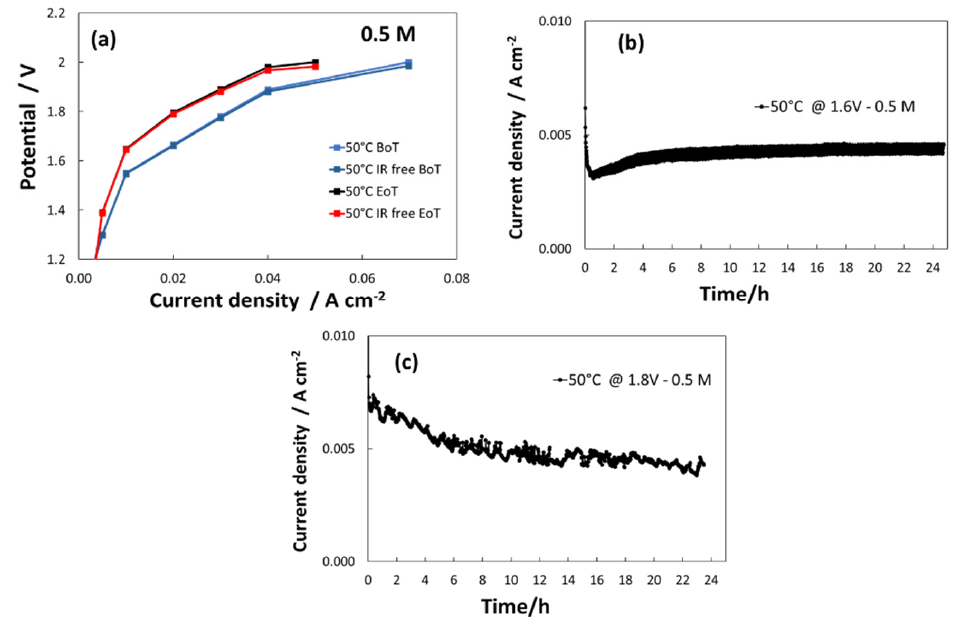
Figure 6. ( a ) Raw and IR-free polarisation curves before (BoT) and after (EoT) a potentiostatic test at 1.6 V. ( b ) Potentiostatic test at 1.6 V/cell. ( c ) Raw and IR-free polarisation curves before (BoT) and after (EoT) a potentiostatic test at 1.8 V. ( d ) Potentiostatic test at 1.8 V/cell. Cell-based on CuOx –